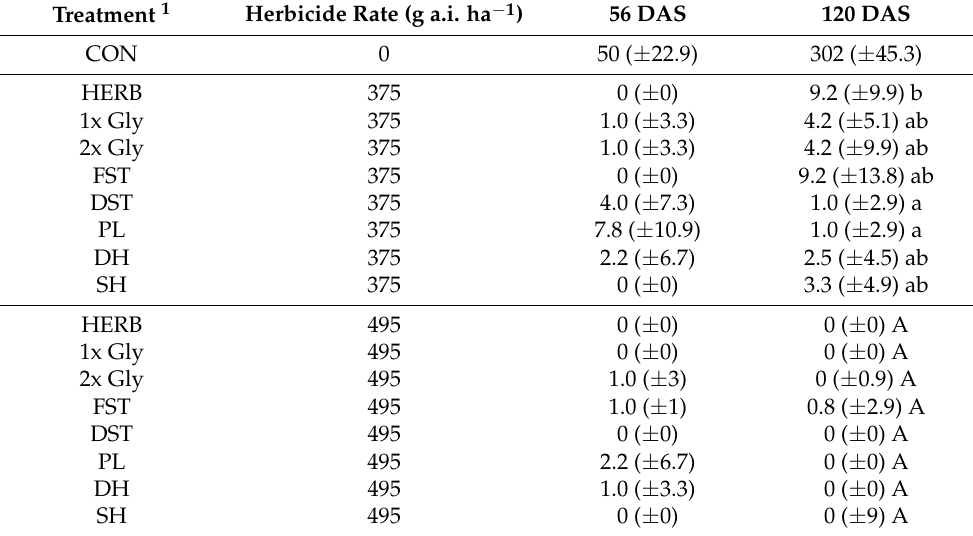
Table 5. A. myosuroides density (plants m − 2 ) 56 DAS and 120 DAS at Risp. Levels of significance are shown behind the result for each date separately. Means with different small letters show significant differences within the herbicide rate of 375 g a.i. ha − 1 according to Tukey’s HSD test at α ≤ 0.05. Means with different capital letters show significant differences within the herbicide rate of 495 g a.i. ha − 1 according to Tukey’s HSD test at α ≤ 0.05. Treatment 1 Herbicide Rate (g a.i. ha − 1 )